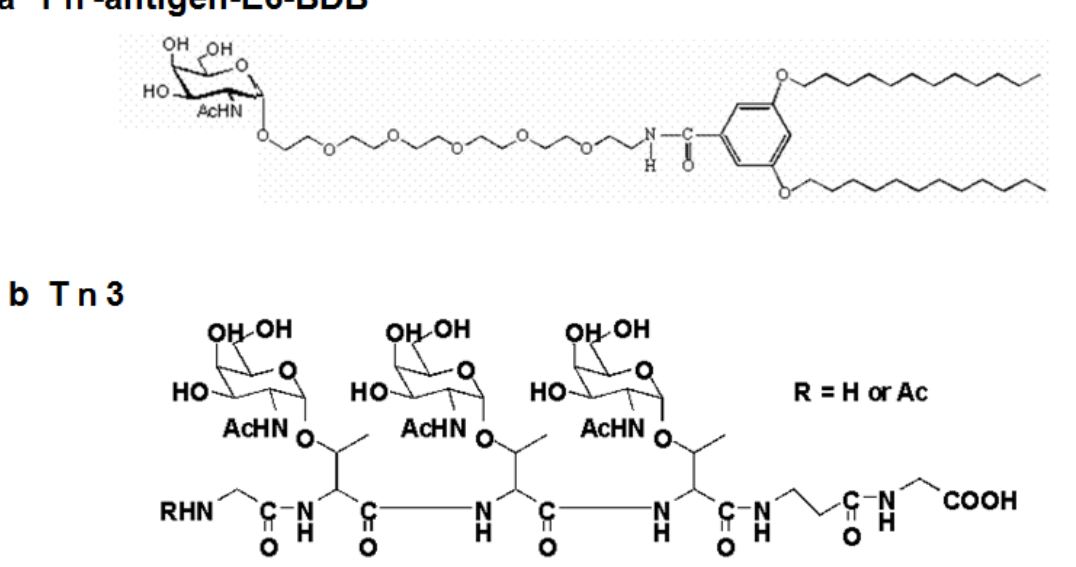
Figure 2. Carbohydrate probes used for the panning and screening of phages